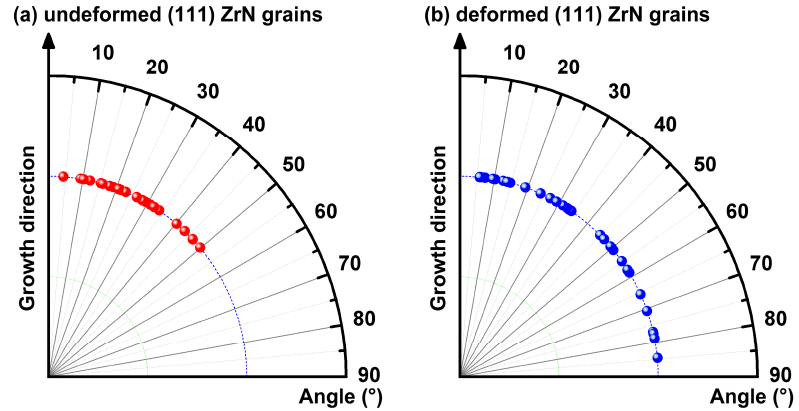
Figure 6. The angular deviations in growth directions between the (111) ZrN grains and the ZrN/Si 3 N 4 multilayer coating: ( a ) shows the angular deviation in growth directions between the undeformed (111) ZrN nanograins and the multilayer coating; ( b ) illustrates the angular deviation in growth directions between the deformed (111) ZrN nanograins and the multilayer coating.